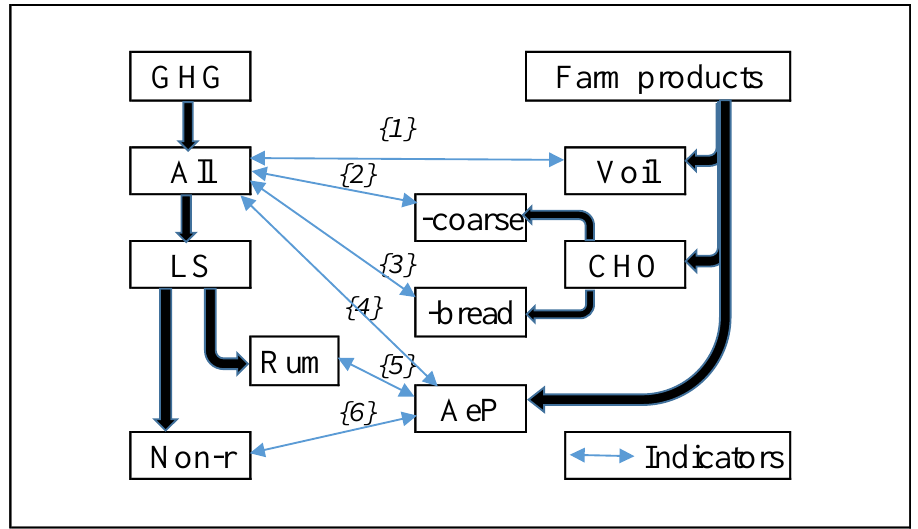
Figure 2. Sustainability metrics indicators for farm products relating Greenhouse Gas (GHG) emissions from all farm types (All), all livestock (LS), ruminant livestock (Rum), and non-ruminant livestock (Non-r) with farm products including animal-equivalent protein (AeP), vegetable oils (Voil), and carbohydrates (CHO), either bread or coarse quality.